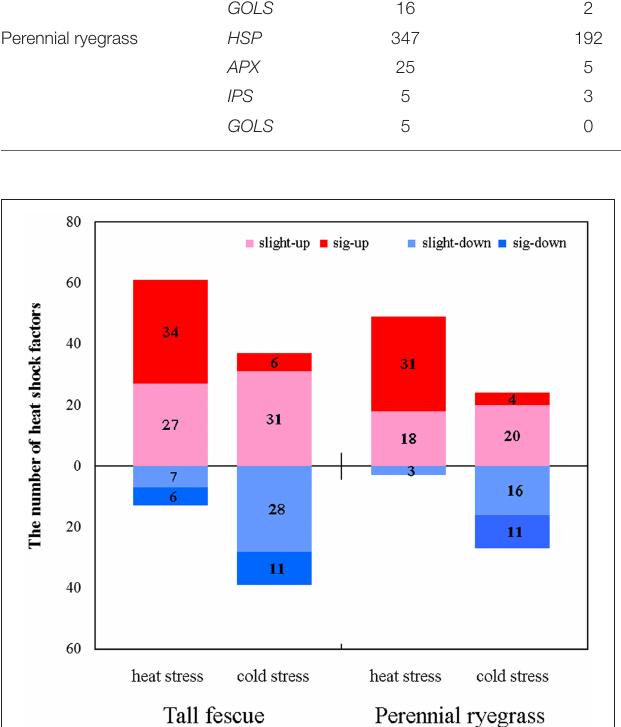
FIGURE 4 | The expression patterns of heat shock factors in the tall fescue and perennial ryegrass under heat and cold stress. Slight-up (pink) indicates insignificantly upregulated Hsf genes, sig-up (red) represents significantly upregulated Hsf genes, slight-down (light blue) denotes insignificantly downregulated Hsf genes, and sig-down (blue) denotes significantly downregulated Hsf genes. Significant differences in transcript expression levels were determined by setting the thresholds for false discovery rate as “(FDR) < 0.001” and “|log 2 Ratio| ≥ 1,” where ratio indicates the fold-change of FPKM values for the treatment and control